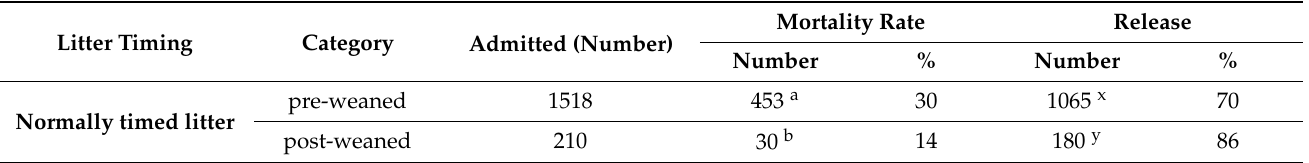
Table 1. Outcome of juvenile European hedgehogs admitted to wildlife rehabilitation centres from 2011 to 2020 divided into four categories by weight and timing of litter (data are from the 3441 indi- viduals with known